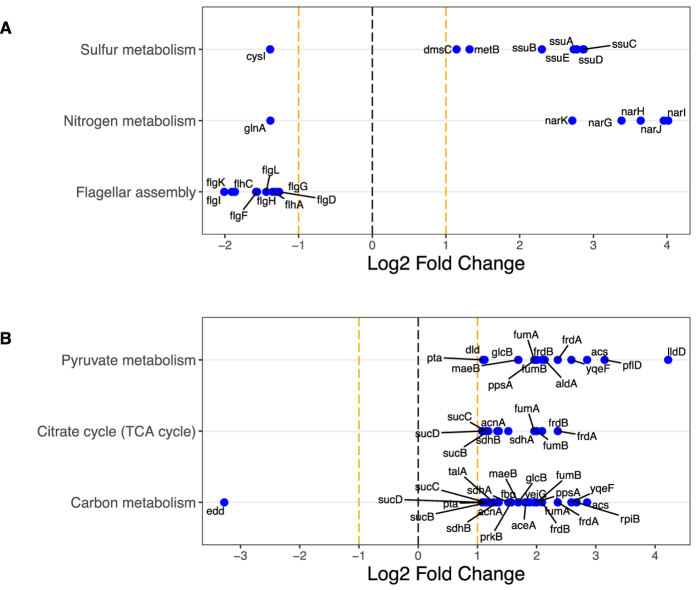
Examples of significantly differentially expressed KEGG pathways and associated genes.The top differentially expressed KEGG pathways are shown along the y axis, and the relative fold change of the corresponding genes is shown along the x axis. For each KEGG pathway, we show up to 10 of the most significantly changing genes. (A) Differentially expressed mRNAs under high Mg2+ levels in exponential phase against the control of samples at base Mg2+ level in exponential phase. (B) Differentially expressed proteins under lactate as carbon source in exponential phase against the control of samples with glucose as carbon source in exponential phase. Significant changes for all conditions are shown in Supplementary Figures 2–33.